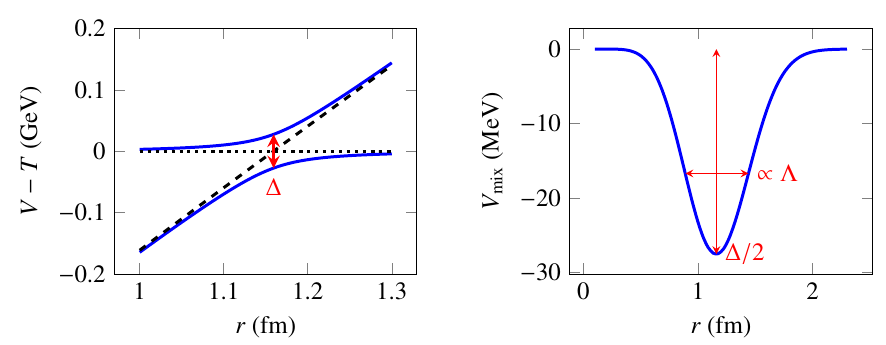
Figure 2. Left: phenomenological lowest and first excited Born-Oppenheimer potentials including sea quarks (solid lines), against the quarkonium potential (dashed line) and threshold mass (dotted line). Right: mixing potential between the quark-antiquark and open-flavor meson-meson